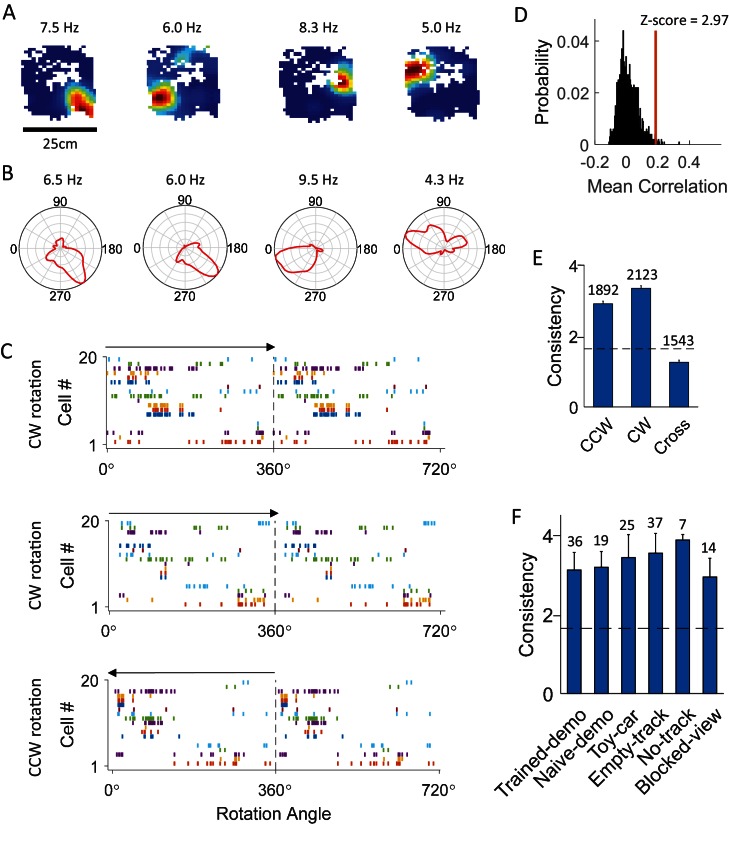
CA1 cells displayed consistent firing sequences during rotation events in the box.(A) Rate maps of example cells in the box during rotation events. Each color plot shows mean firing rate of a cell versus the animal’s head position in the box. Number on top of each map: peak rate. (B) Firing rate curves of the same cells. Each plot is the mean firing rate at each bin of head direction during the rotation events. Number on the top of each curve: peak rate. (C) Firing sequences of all the simultaneously recorded rotation-consistent cells during a CW rotation (top), another CW rotation (middle), and a CCW rotation event (bottom). Each row plots spike rater of one cell versus the animal’s head direction for a 360° cycle twice. Cells were ordered by their peak firing angles. Arrow: rotation direction. Note the consistent sequences during all the 3 rotation events (same firing order between the 2 CW events; reverse firing order between CCW and CW events with cells firing at similar angles during both CW and CCW events). (D) Actual mean cross-event correlation (red line) and distribution of shuffle-generated correlation values for an example rotation-consistent cell. Z-score: z-scored mean cross-event correlation (rotation-consistency). (E) Average rotation-consistency for all rotation-active cells within CW events, within CCW events and cross CW and CCW events (cross). Dashed line: threshold (Z = 1.645, p<0.05, z-test) for a cell to be rotation-consistent. t = 21, p=3.4 × 10–94 (paired t-test between cross and within-CW); t = 17, p=3.5 × 10–61 (between cross and within-CCW); Number above each bar: number of cells active in CCW or CW events, or both (only a subset active in both). (F) Average rotation-consistency under different box conditions. F(5,133) = 0.62, p=0.62 (one-way ANOVA across all conditions). Each bar is the average over all the sessions (all cells within a session were averaged to get a mean value) under a condition. Number above each bar: number of sessions.